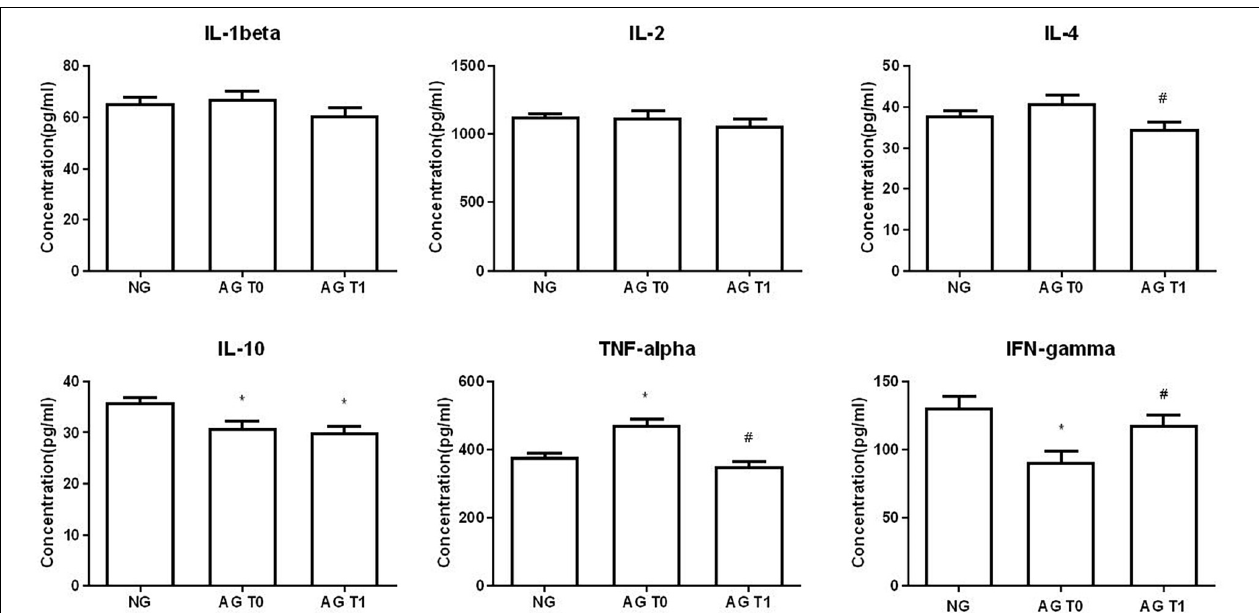
FIGURE 6 | Cytokine concentration in peripheral blood. *Compare with the healthy elderly people, P < 0.05. # Compare with the conditions before treatment, P < 0.05.